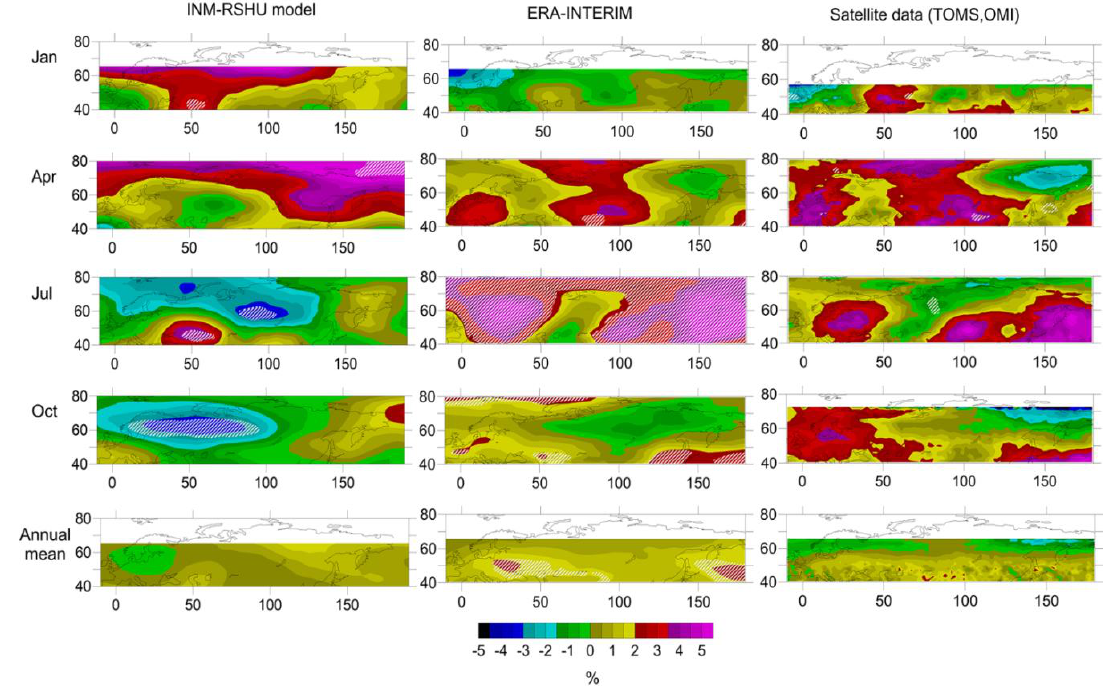
Figure 7. Difference in the average of Eery anomalies for the period 2000–2015 and the period 1979–1999 due to total ozone changes calculated from the different datasets. Statistically significant differences at 95% are shown by white hatching. Note that the left-bottom panel is identical to the bottom panel of Figure 5. X-axis—is longitude, Y-axis—is latitude.